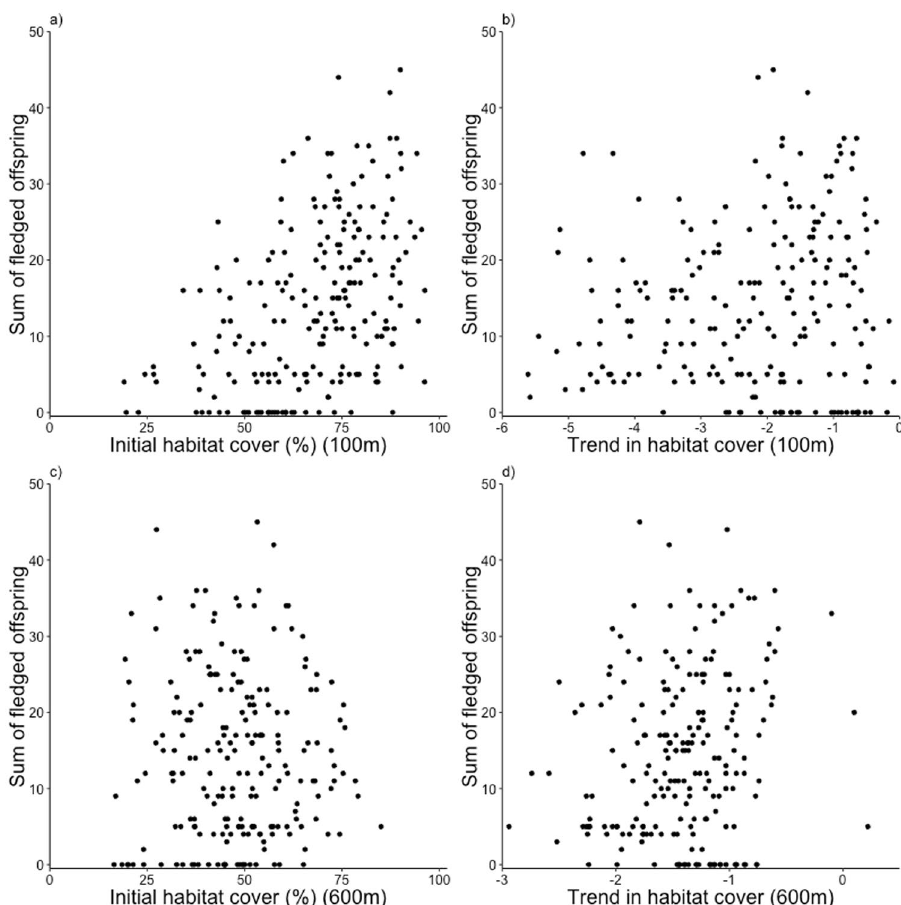
Figure 4. Scatter plots showing the association between the level of initial habitat cover and the number of fledged offspring summed per nest box site, and the association between change in habitat cover, measured by factor scores, and the summed number of fledged offspring. Panel (a) shows the association between the initial level of habitat cover and the number of fledged offspring at the territory core scale, while panel (b) shows the association between change in habitat cover and fledged offspring at the same spatial scale. Panels (c) and (d) show the same associations at the landscape scale. Note that factor scores are set on an arbitrary scale, with the mean value corresponding to the value of the factor mean (see Table